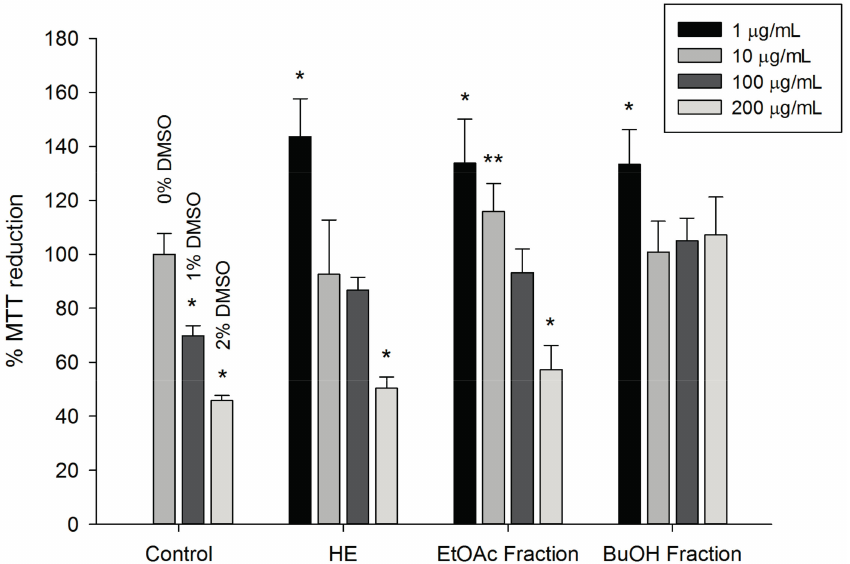
Figure 2. The MTT assay performed with a macrophage cell line (RAW 264.7). The BuOH fraction (1, 10, 100, and 200 µ g/mL) was dissolved in distilled water resulting in a final concentration of 10 mg/mL, whereas the hydroethanolic extract—(HE, 1, 10, 100, and 200 µ g/mL) and the EtOAc fraction (1, 10, 100, and 200 µ g/mL) were dissolved in dimethyl sulfoxide (DMSO), resulting in a final concentration of 10 mg/mL. DMSO at two concentrations (1% and 2%) were used to demonstrate its effect on MTT concentration. ** p < 0.01 and * p < 0.05 and tested group compared to the control group (0%